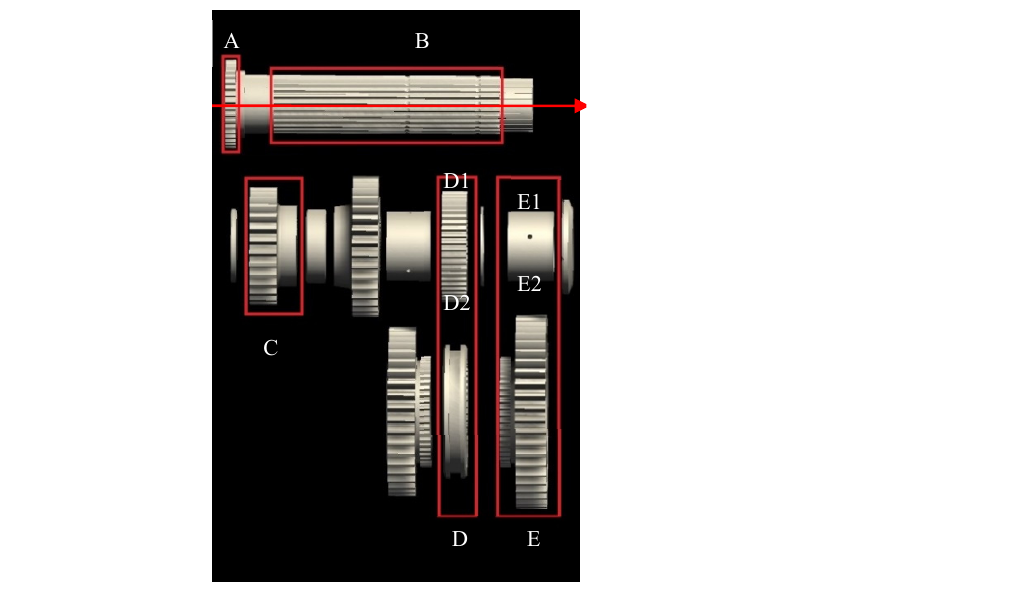
Figure 18. Assembly sequence diagram.